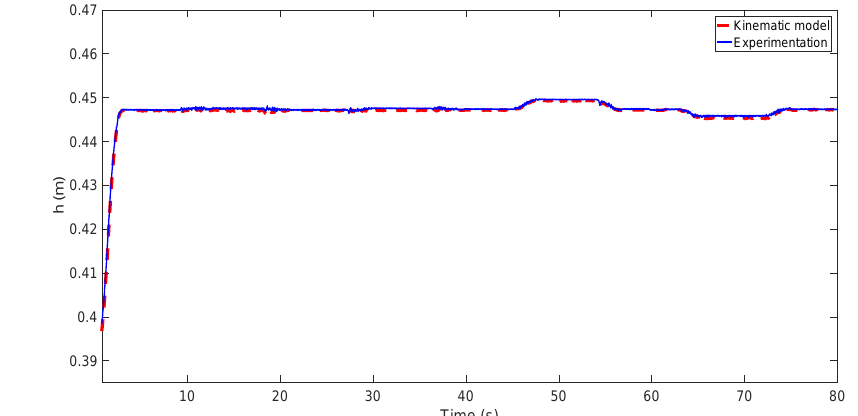
Figure 10. Validation of the height of the centre of frame {F}.